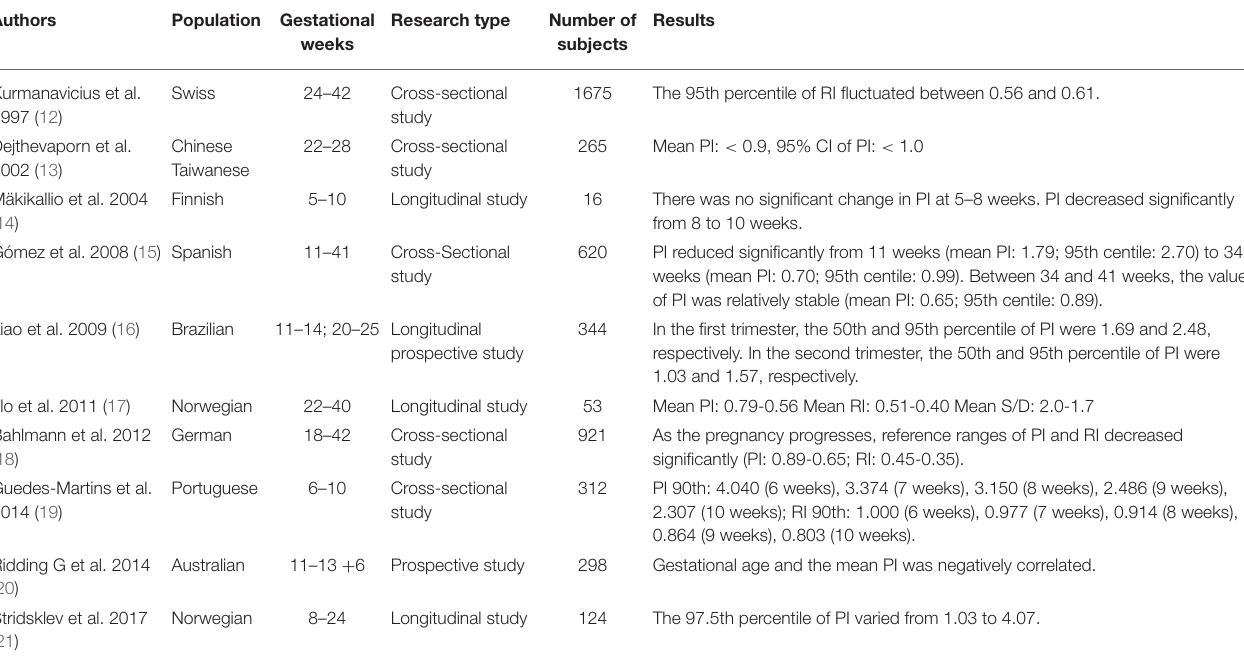
TABLE 1 | Studies on uterine artery Doppler in normal pregnant